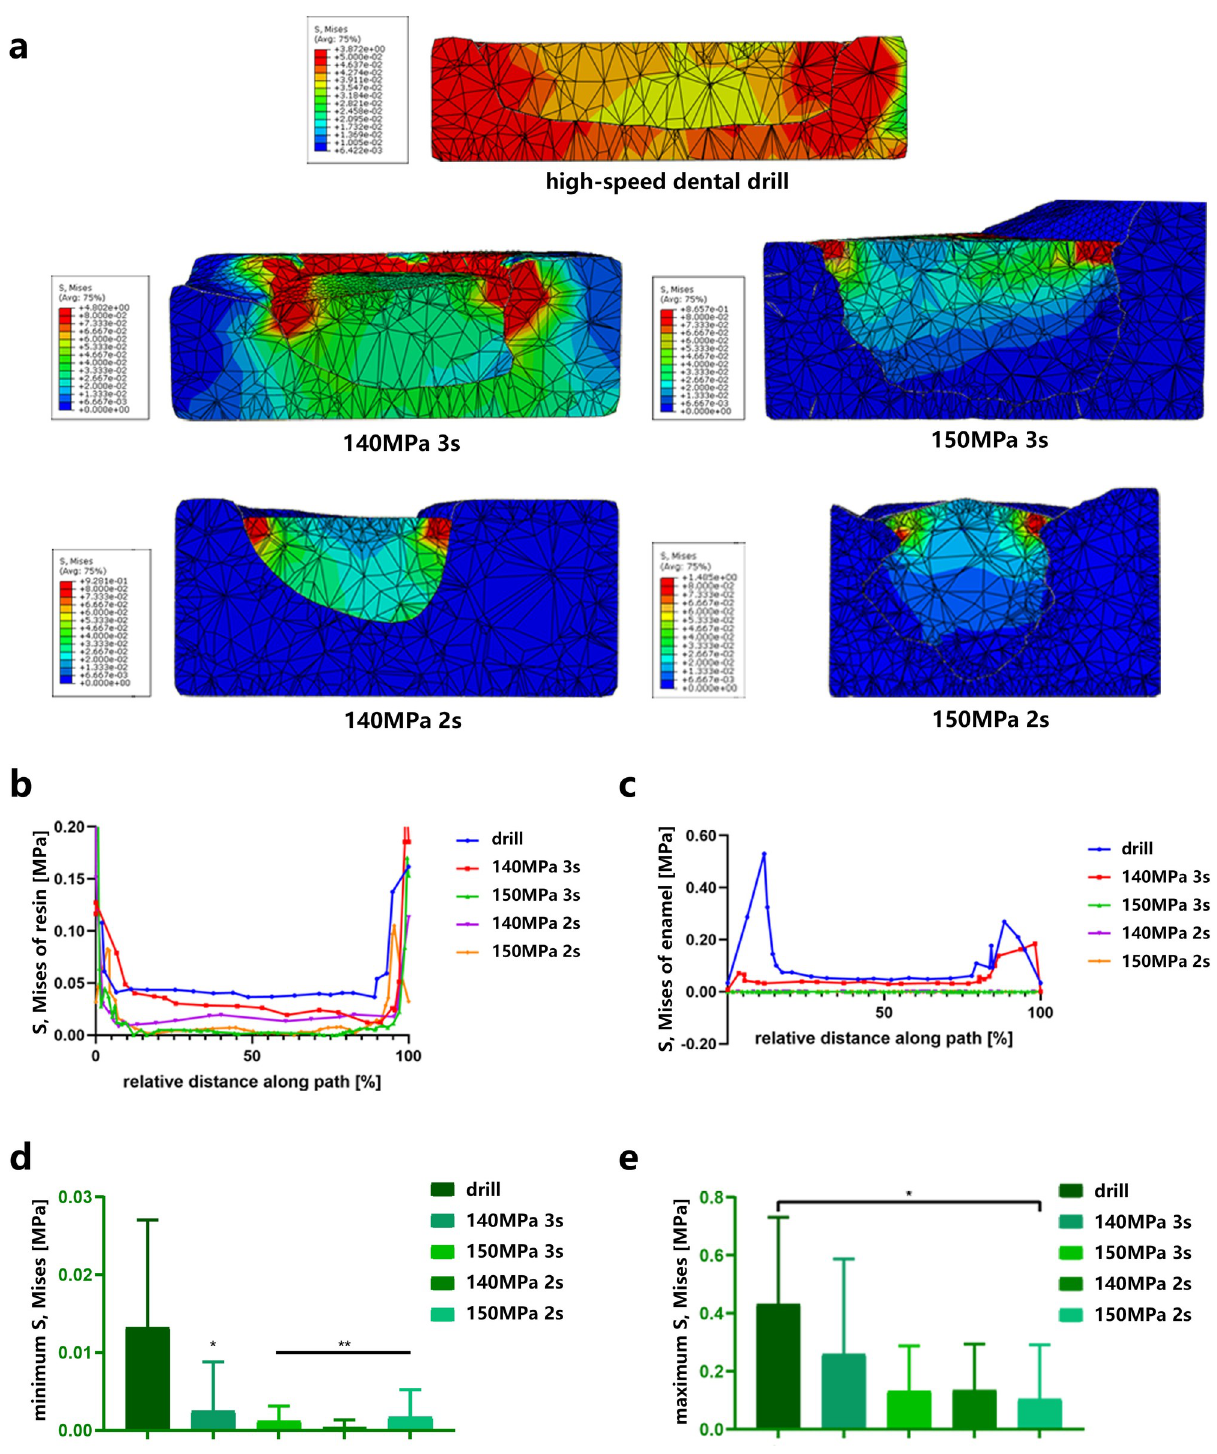
Fig 7. Prediction of bonding strength through simulation with FEA. a , Heat map of the Von Mises stress of the model based on the cavity prepared with a water jet or a high-speed dental drill. b , The Von Mises stress of the resin interface prepared with a water jet or a high-speed dental drill (n = 10). c , The Von Mises stress of the enamel interface prepared with a water jet or a high-speed dental drill (n = 10). d , The minimum Von Mises stress of the enamel interface prepared with a water jet or a high-speed dental drill (n = 10). The asterisk represents statistical significance between the high-speed dental drill group and the water jet group. Data represent the mean ( ± SD), � p < 0.05, �� p < 0.01. e , The maximum Von Mises stress of the enamel